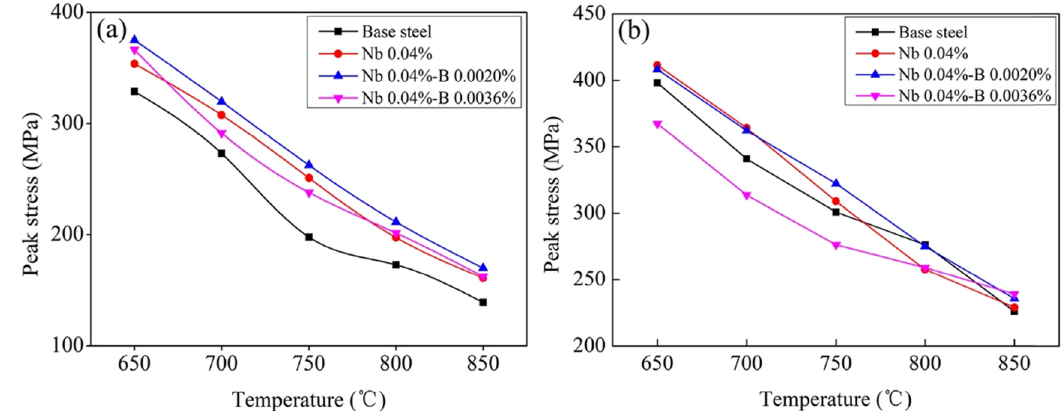
Figure 4: Peak stress curves with a strain rate of 0.005 s − 1 ( a ) and 0.5 s − 1 ( b ) of the test steels.